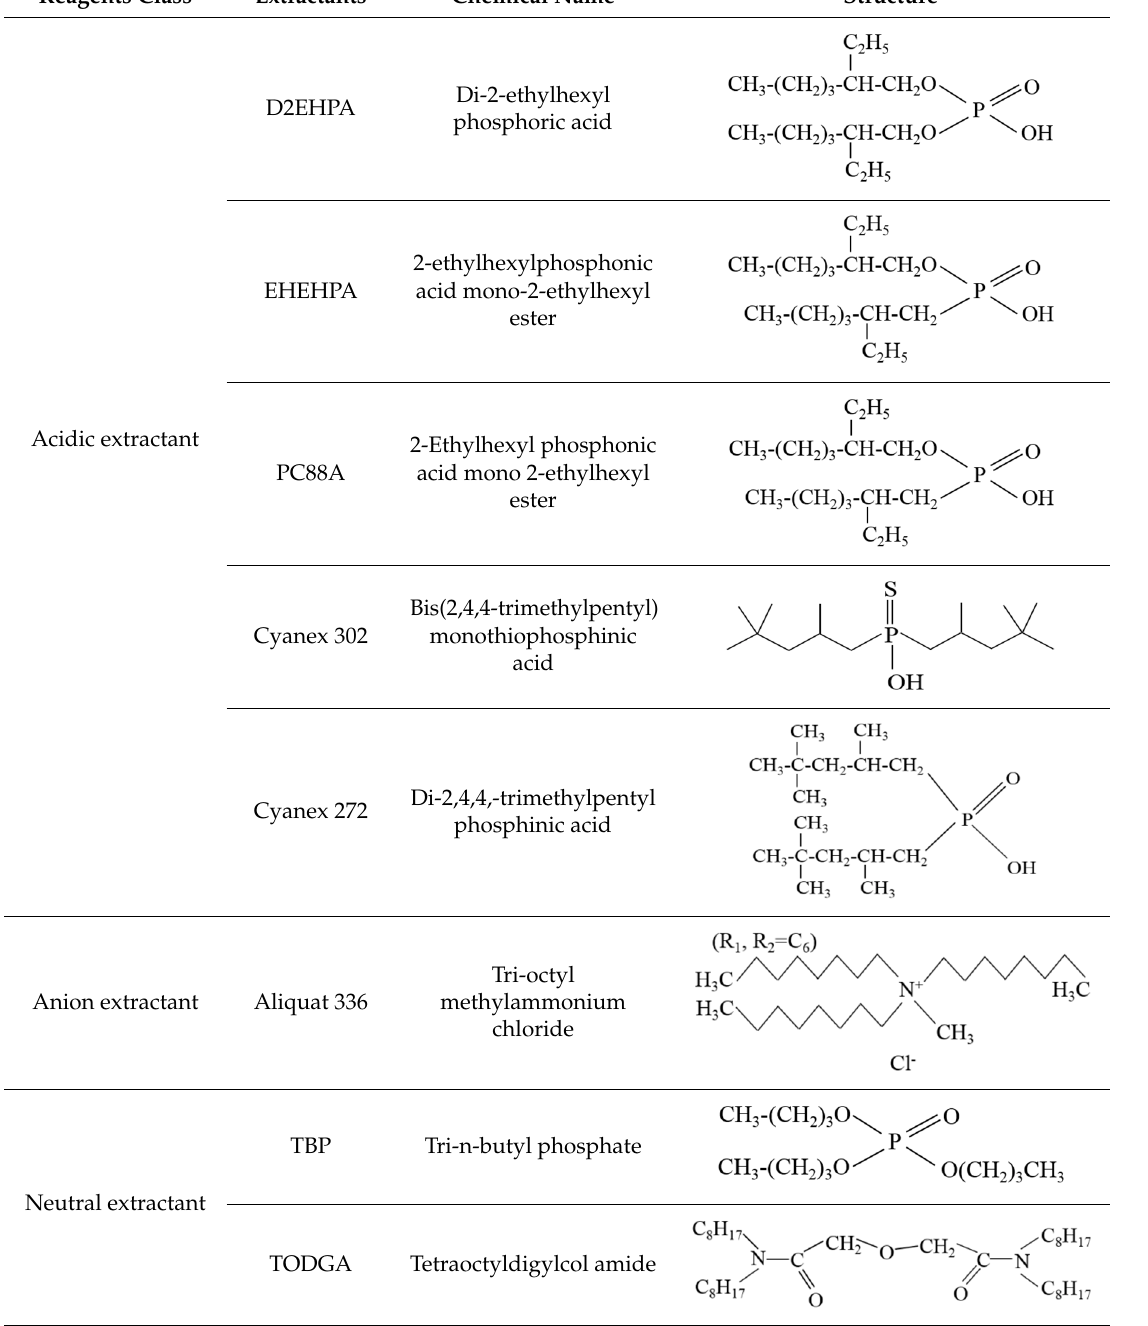
Table 4. Different organic solvents used for the extraction of REEs.